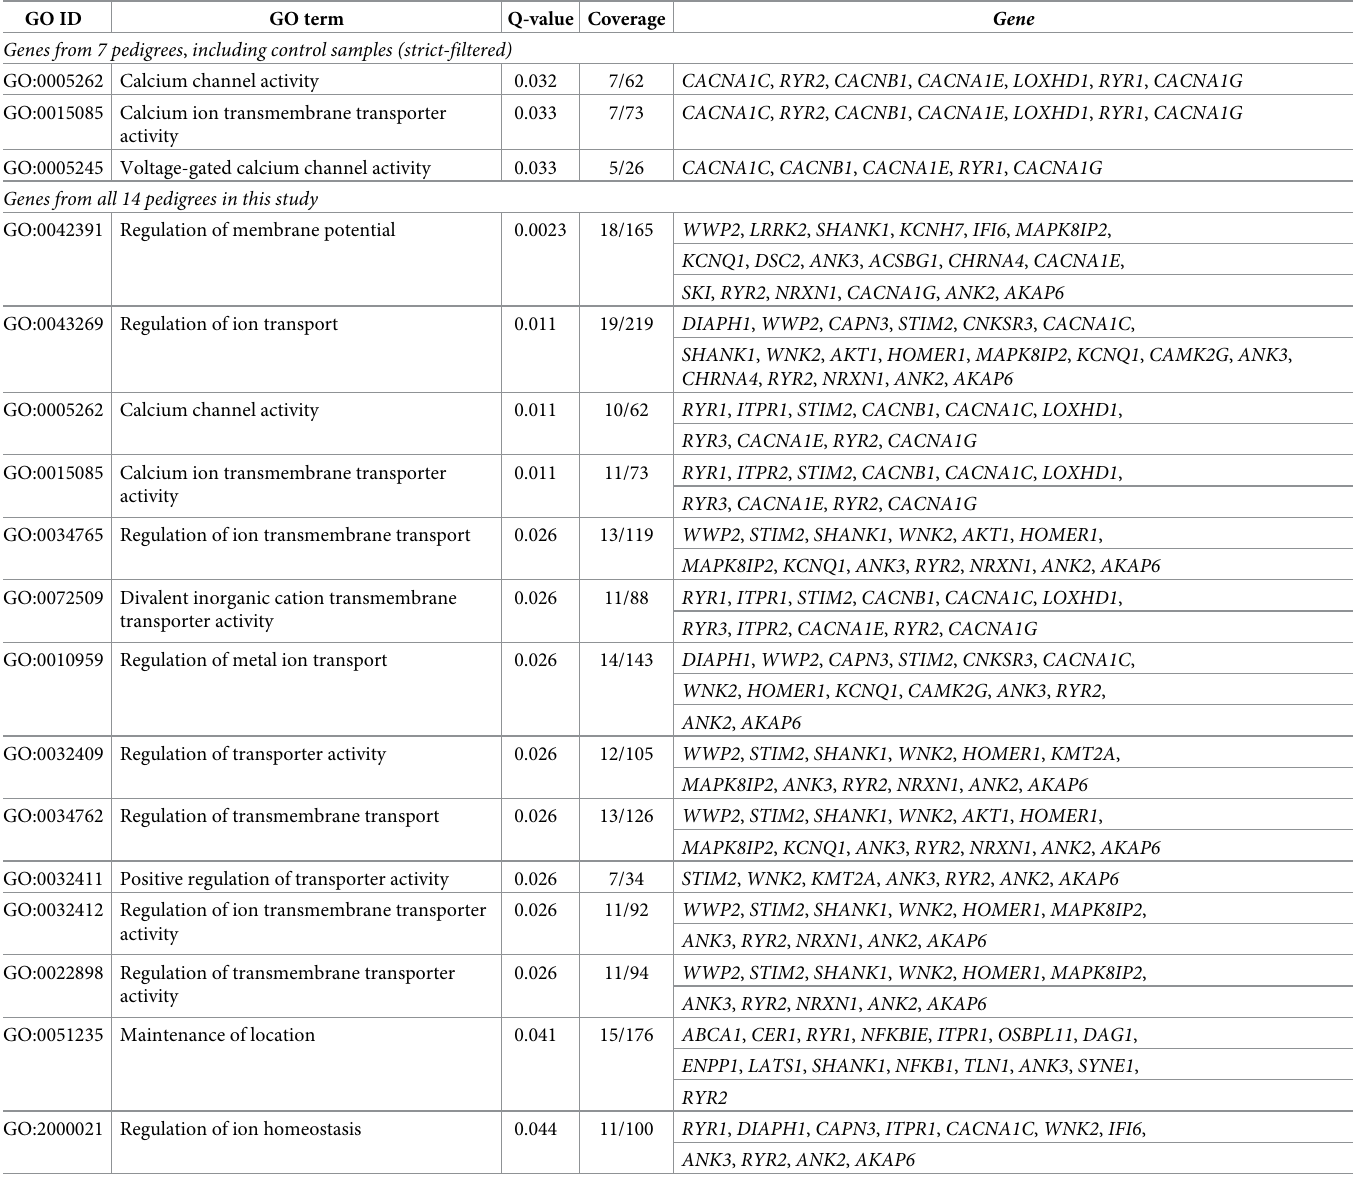
Table 3. GO analysis